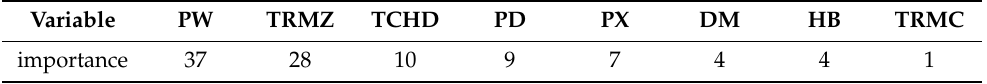
Table 10. Importance of variables of Masson pine.